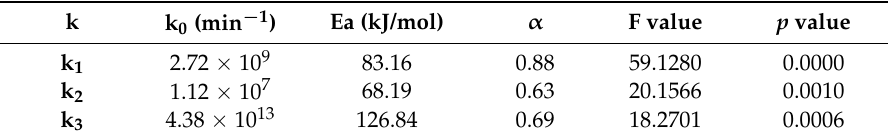
Table 2. The reaction activity energies and other parameters in kinetic models of xylan dissolutions and degradation during EACO